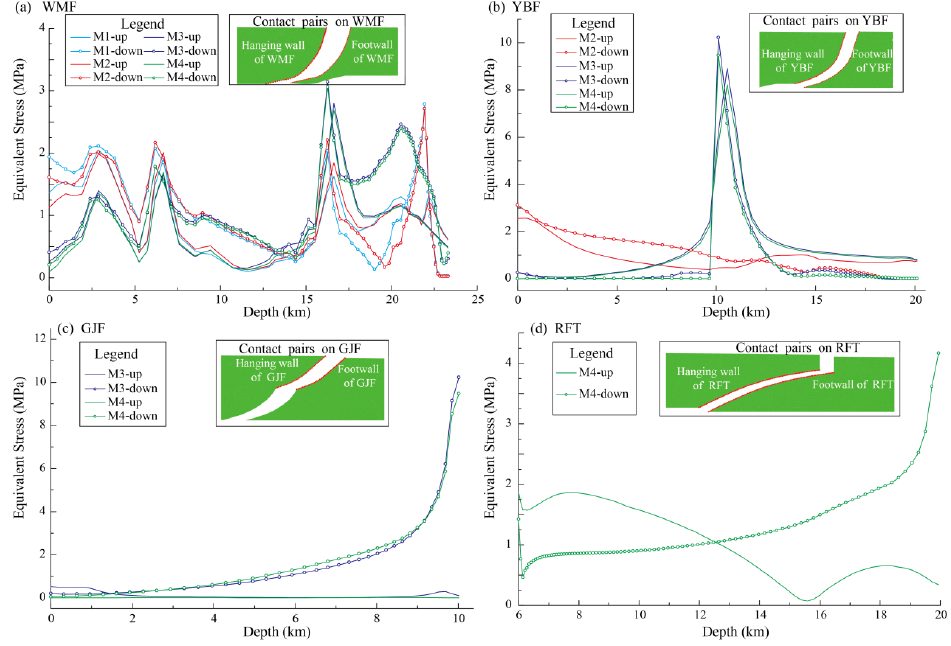
Figure 6. Distribution of cumulative equivalent stress on the hanging wall and footwall of the fault in LMS. ( a – d ) are WMF, YBF, GJF, and RFT from Model 1 to Model 4; Solid line: Equivalent stress on the hanging wall of the fault; Solid line with dots: Equivalent stress on the footwall of the fault; Red dots: Contact pairs on the fault; Cyan color: Results of Model 1; Red color: Results of Model 2; Blue color: Results of Model 3; Green color: Results of Model 4; Model 1 is simplified to “M1”, hanging wall of the fault is simplified to “up” and footwall of the fault is simplified to “down” in the legend; The ordinate represents the magnitude of equivalent stress which unit is MPa (1 × 10 6 Pa), and the abscissa represents the